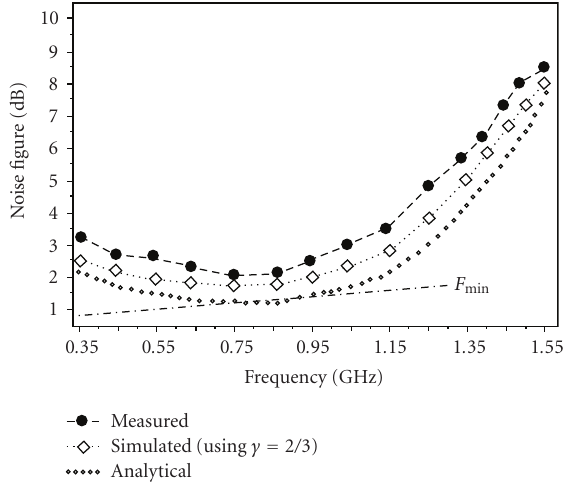
Figure 5: Forward gain, S 21 (in dB) of the RFID LNA.